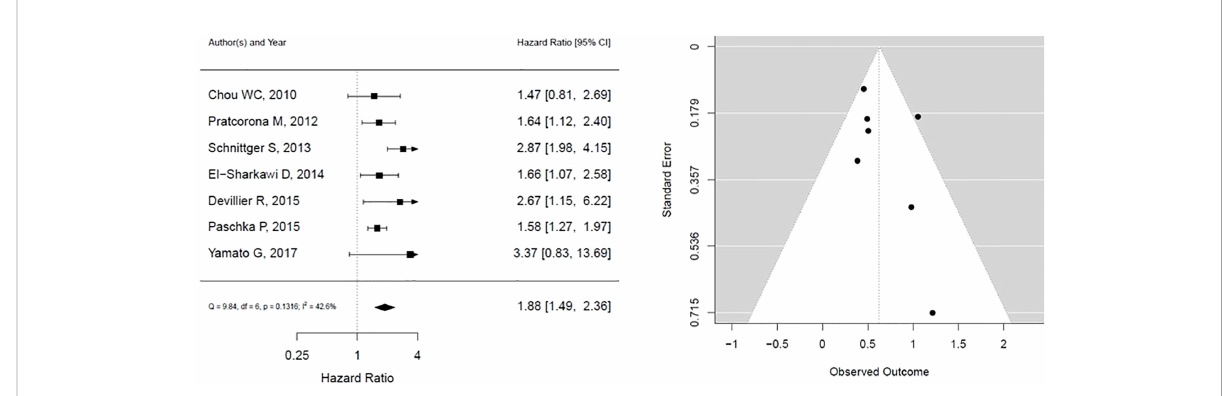
FIGURE 2 Forest plot and funnel plot of the HR for overall survival in ASXL1 mutation. The fi rst author and year of publication is provided for each study. The hazards ratio (boxes) with 95% con fi dence intervals (CI, horizontal lines) were calculated, the pooled hazards ratio (diamond) was estimated using random effect model. The P value for comparing heterogeneity between subgroups was calculated using I-squared. ASXL1, Additional Sex Combs-Like 1.